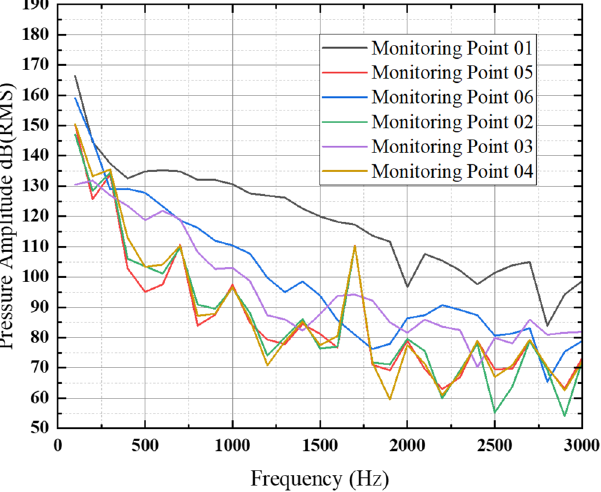
Figure 19. Line graph of the frequency response curve of the equal-diameter nozzle with a 3000 Hz near-field sound pressure level.